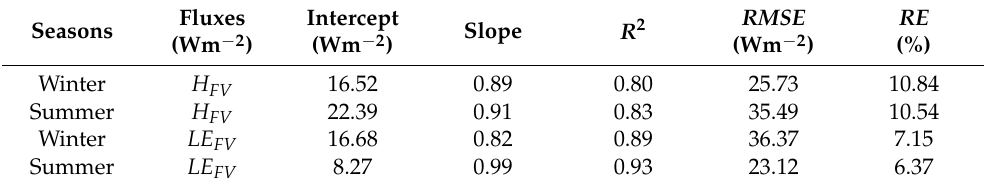
Figure 8. Comparison of estimated latent heat flux against the measurements of the eddy covariance system during two seasons. ( a ) Half-hourly comparison of LE FV and LE EC for unstable conditions during Season 1 (winter, 2018). ( b ) Half-hourly comparison of LE FV and LE EC for unstable conditions during Season 2 (summer, 2019). Table 3. Regression statistics of half-hourly estimations of the FV and EC